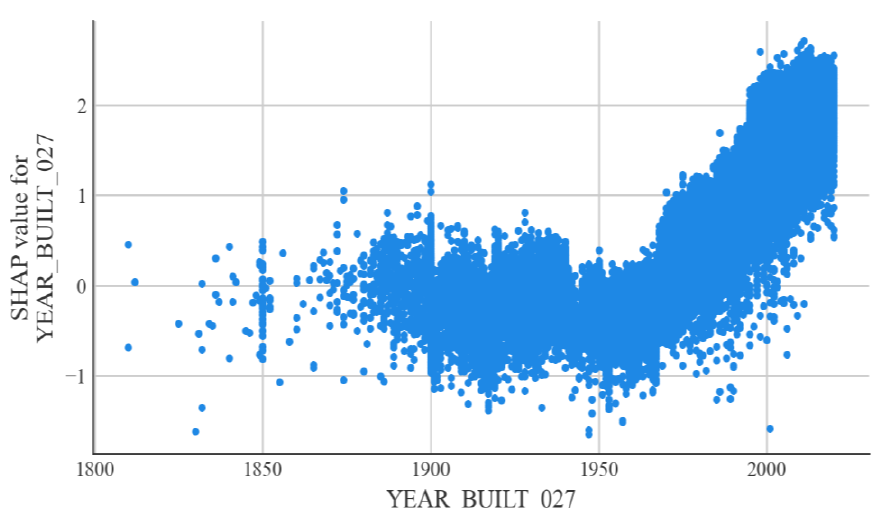
Figure 8. Bridge construction year characteristics dependency chart.